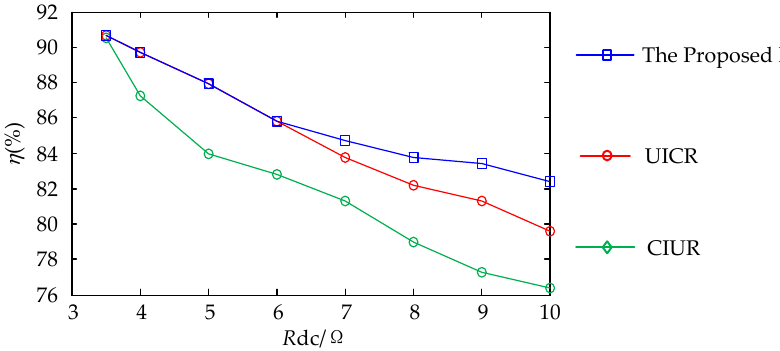
Figure 17. The efficiency of the IPT system when changing the DC load when δ equals 150 mm.